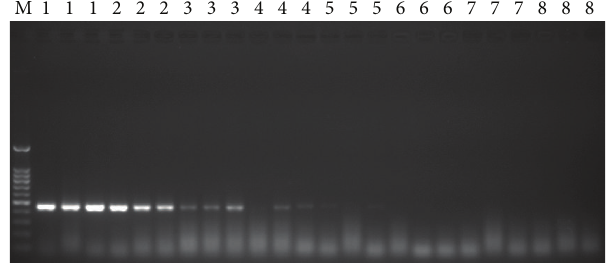
Figure 2: Sensitivity test of conventional PCR based on eight ten- fold serial dilutions of smut pbE DNA. M: 100bp DNA ladder marker; Lane 1, 100pg/ 𝜇 L; Lane 2, 10pg/ 𝜇 L; Lane 3, 1pg/ 𝜇 L; Lane 4, 100fg/ 𝜇 L; Lane 5, 10fg/ 𝜇 L; Lane 6, 1fg/ 𝜇 L; Lane 7, 100ag/ 𝜇 L; Lane 8, 10ag/ 𝜇 L.